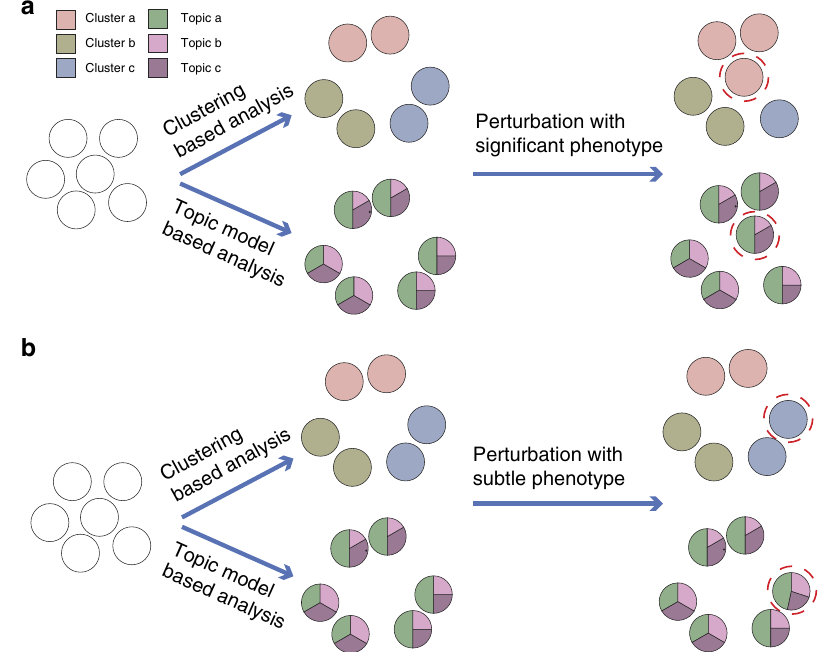
Fig. 2 Comparisons between traditional clustering based analysis and topic model based analysis for single-cell CRISPR screening data. a Difference between traditional clustering based analysis and topic model-based analysis for single-cell CRISPR screening data when a perturbation has a signi fi cant phenotype on the cells. Both analyses can detect such phenotype change (see the cell sample with red dotted line). b Difference between traditional clustering-based analysis and topic model-based analysis for single-cell CRISPR screening data when a perturbation has a subtle phenotype on the cells. Topic modeling calculates a topic probability pro fi le for each sample while traditional clustering just makes a hard assignment of the sample to each cluster. Therefore, in this way, topic-model-based analysis can detect such phenotype change based on the change of topic probability pro fi le with and without perturbation, while traditional clustering based analysis failed to detect such subtle phenotype change (see the cell sample with red dotted